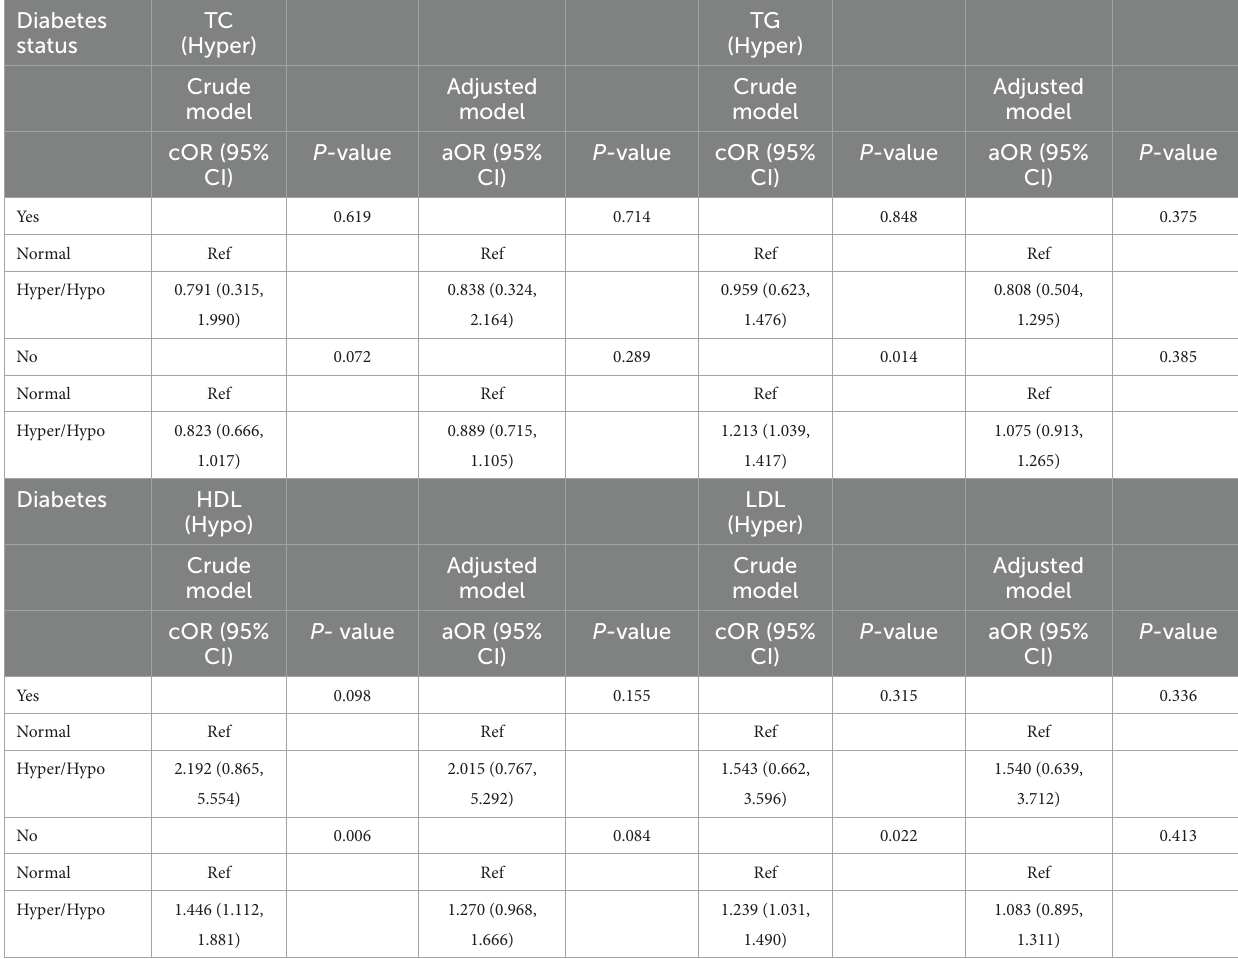
TABLE 9 Odds ratios for associations between triglyceride and cholesterol levels and anti-HBs results stratified by diabetes status. Diabetes